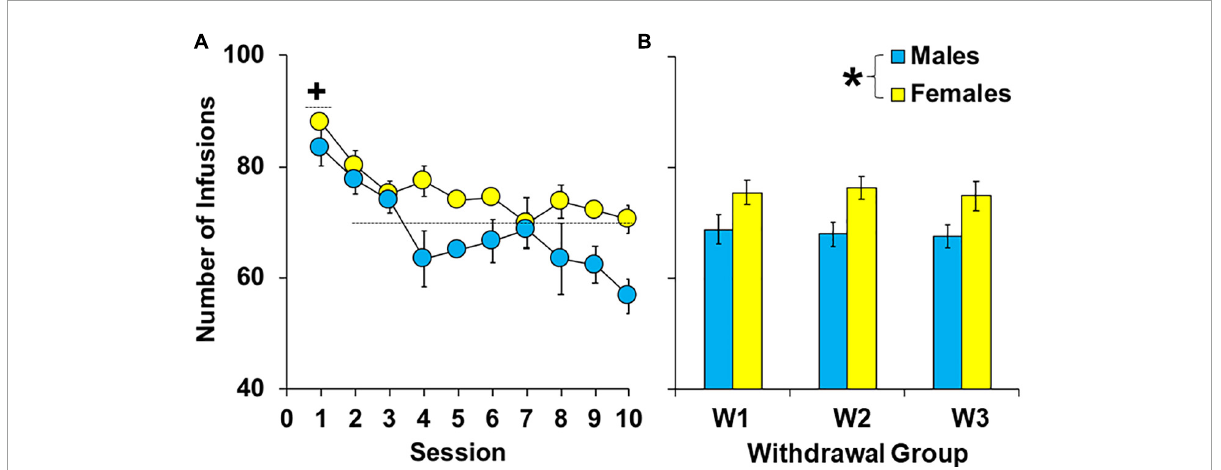
FIGURE2 Effect of sex on cocaine intake during 10 extended-access sessions under a discrete trial procedure. Mean ( ± SEM) number of infusions obtained during each of the ten extended-access sessions (A) and averaged across all extended-access sessions (B) for males and females in the early (W2; n = 13 females, 10 males), intermediate (W7; n = 13 females, 10 males), and late (W14; n = 13 females, 10 males) withdrawal groups. *Significantly higher cocaine intake in females compared to males. + Significantly higher cocaine intake during the first extended-access session compared to later ones (averaged across sessions 2–10) for both